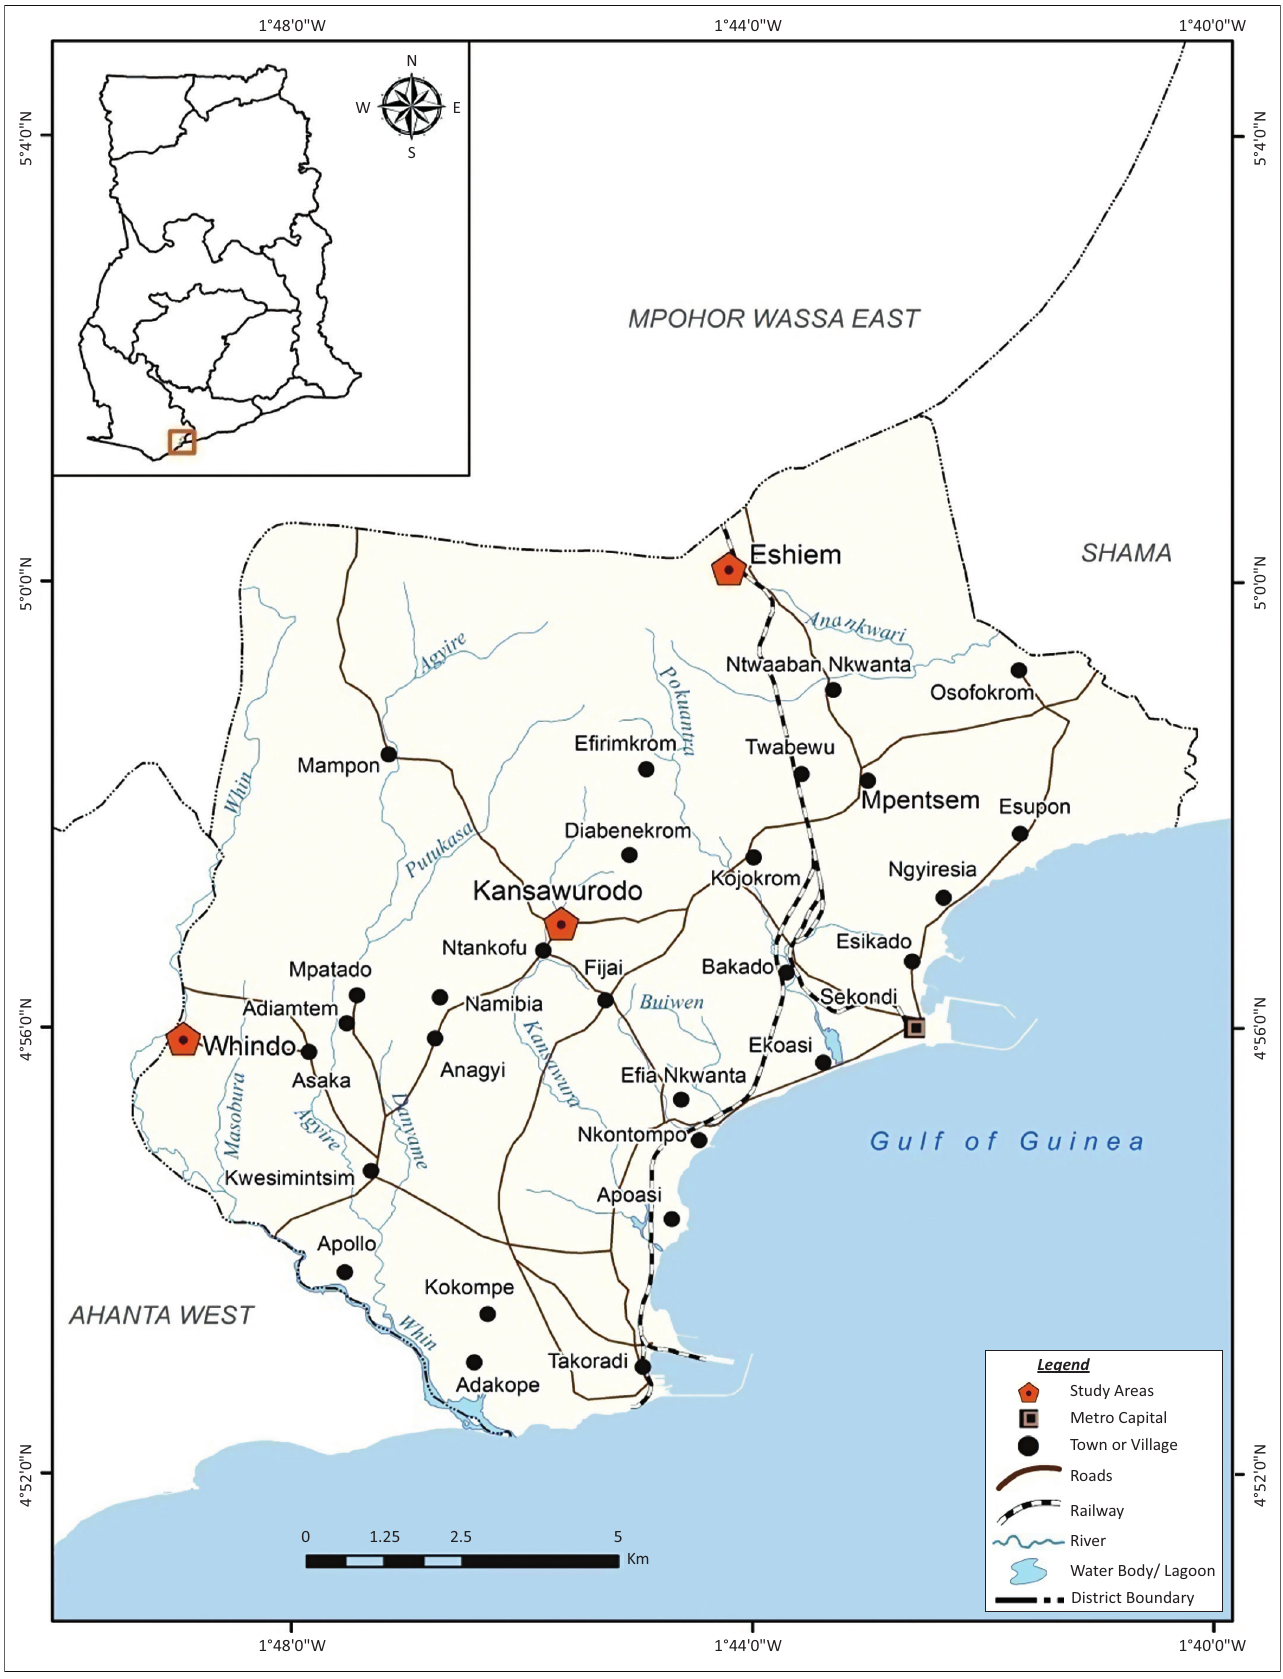
FIGURE 1: The Sekondi-Takoradi Metropolitan Assembly showing the study